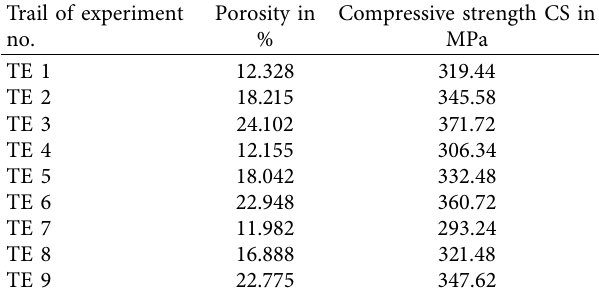
Table 2: Experimental results for the trails of